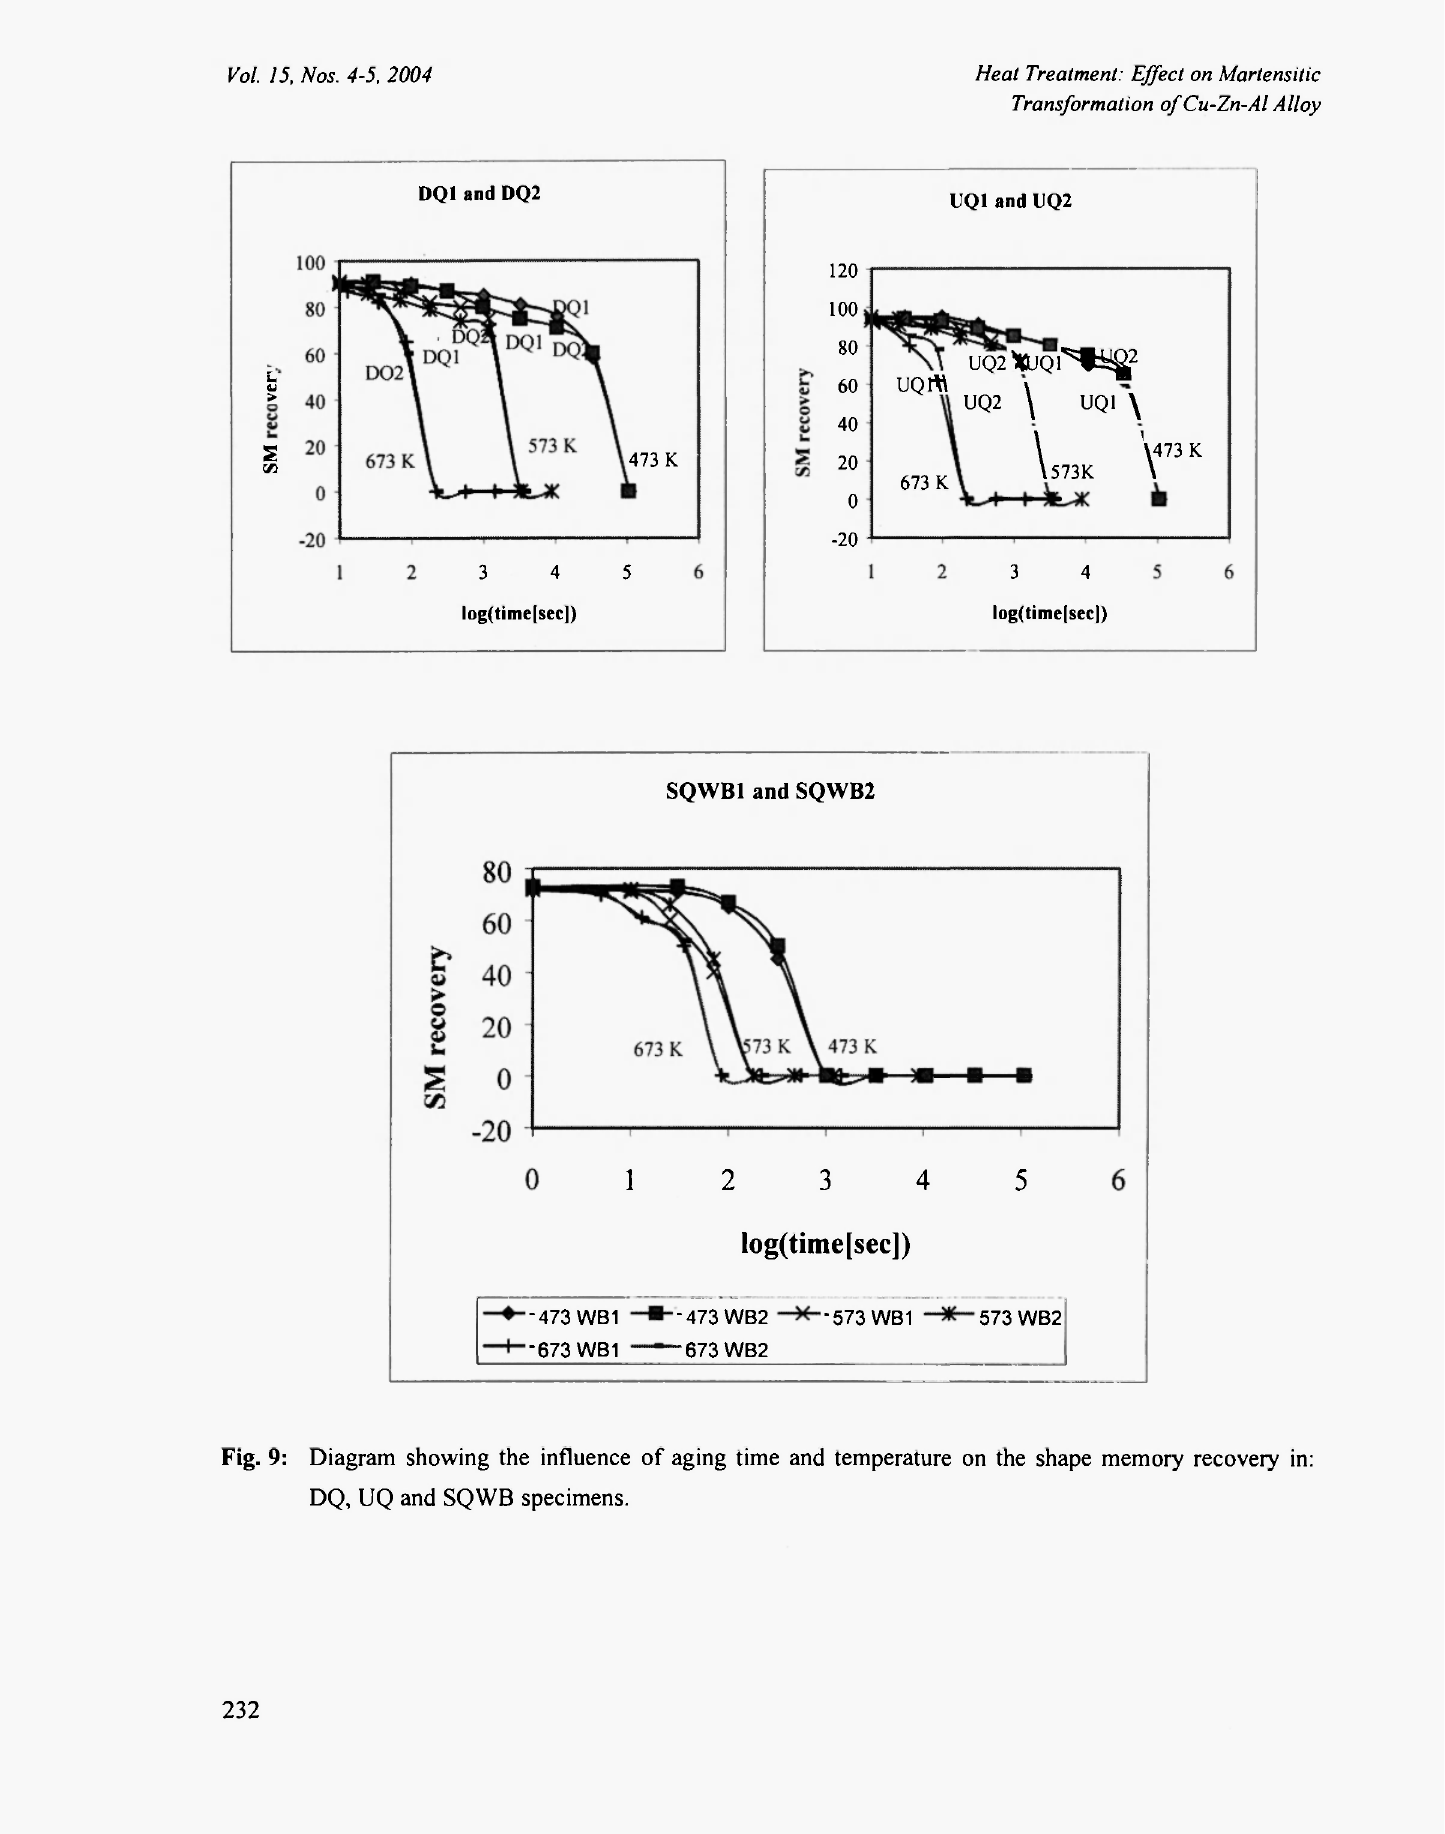
Fig. 9: Diagram showing the influence of aging time and temperature on the shape memory recovery in: DQ, UQ and SQWB